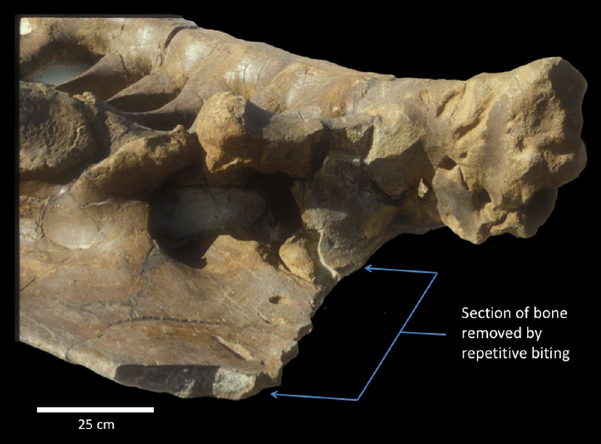
Figure 1. Left ilium of Triceratops sp. (MOR 799) in ventrolateral view with ~80 bite marks attributed to Tyrannosaurus rex . A large portion (~17%) of the iliac crest was removed (bracketed) by repetitive, localized